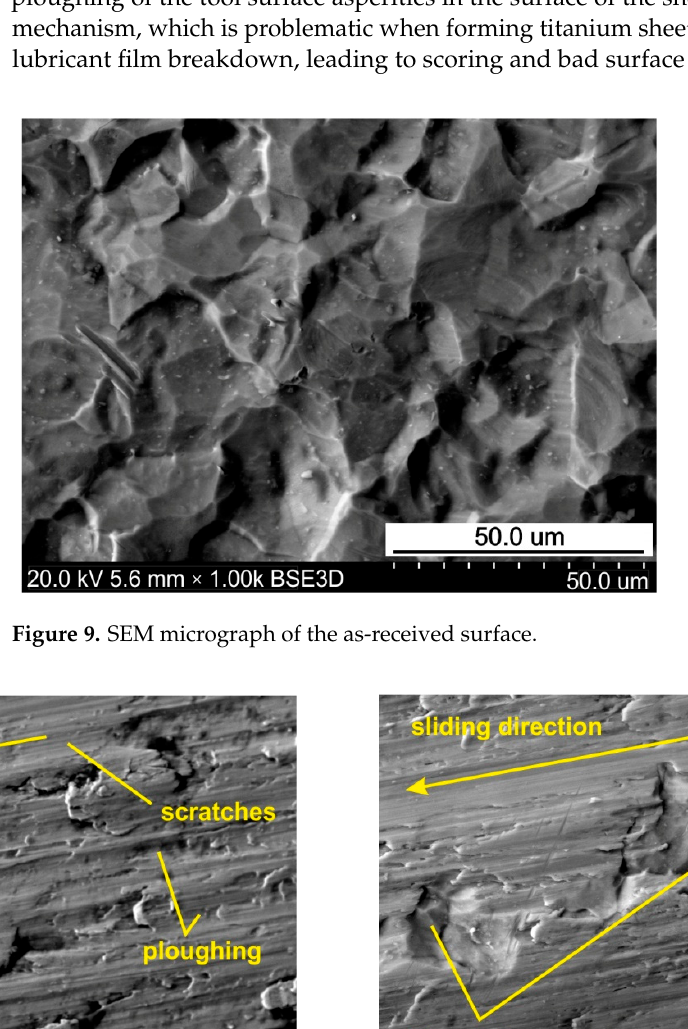
Figure 8. The surface topography of the sheet after a strip drawing test in dry friction conditions, nominal pressure 151 MPa.